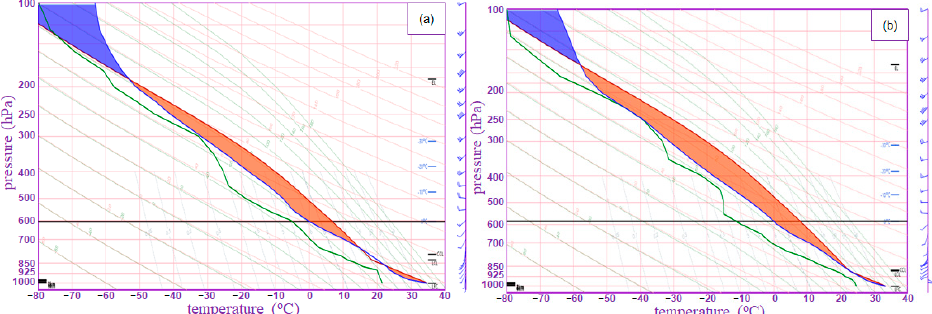
Figure 5. Vertical profiles of temperature (blue line, unit: ◦ C), dew point temperature (green line, unit: ◦ C), and the temperature of adiabatic rise curve of surface air envelope (brown line, unit: ◦ C) above the TUR on the T-logp map (surface observations combined with ERA5 reanalysis data above the boundary layer) at ( a ) 14:00 BT and ( b ) 17:00 BT on 1 August 2019, respectively.